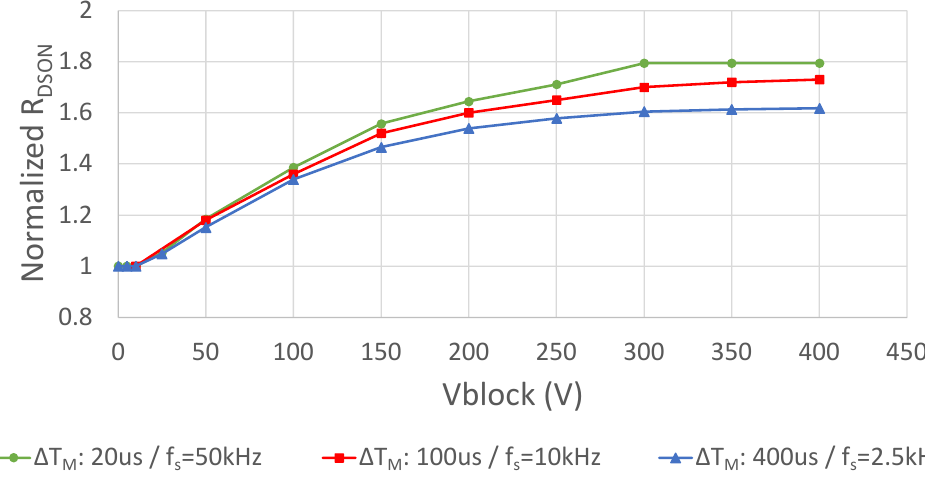
Figure 9. Normalized dynamic R ON VS V block evaluated at ∆ T M = 20 µ s, ∆ T M = 100 µ s and ∆ T M = 400 µ s, with a T block = 500 ns blocking voltage impulse.